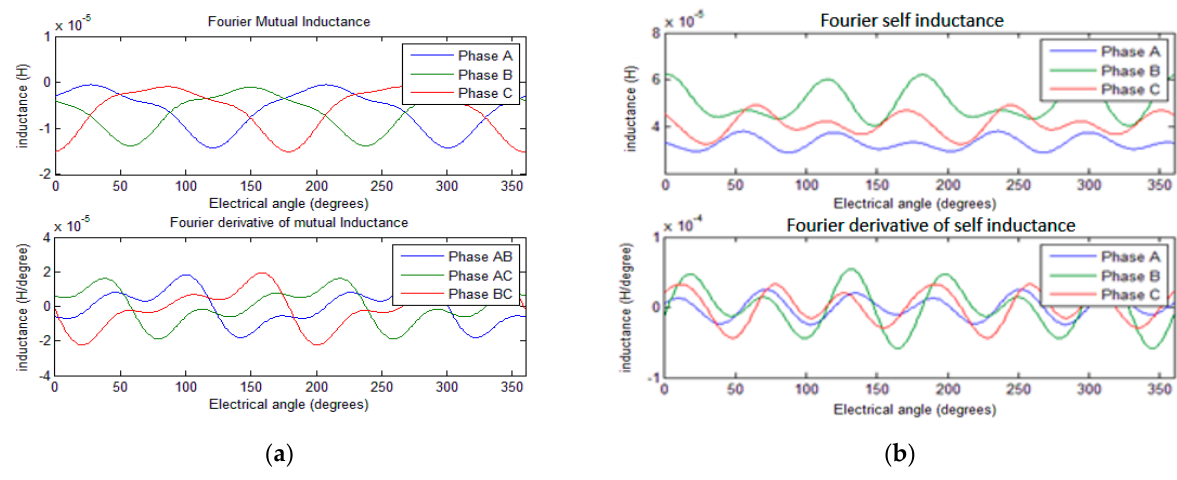
Figure 6. Fourier representations and their derivatives relative to the rotor angle: ( a ) mutual inductance and ( b ) self in- ductance.